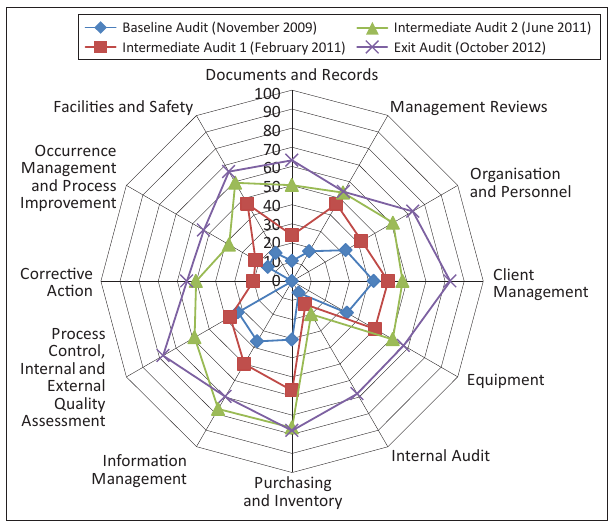
FIGURE 2: Average performance of the five laboratories measured at baseline, first and second intermediate, and exit audits. Average marks are expressed as a percentage of the total for each of the 12 Quality System Essentials sections of the SLIPTA